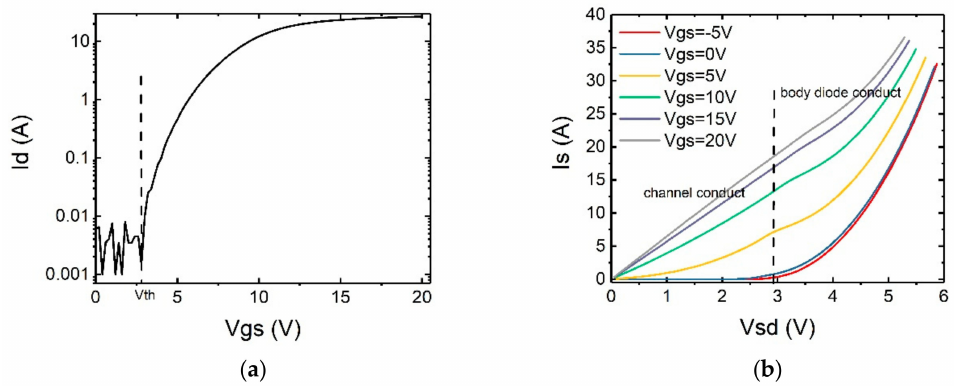
Figure 2. ( a ) Transfer characteristic with V ds = 10 V and ( b ) reverse I-V curves of C2M0160120D from